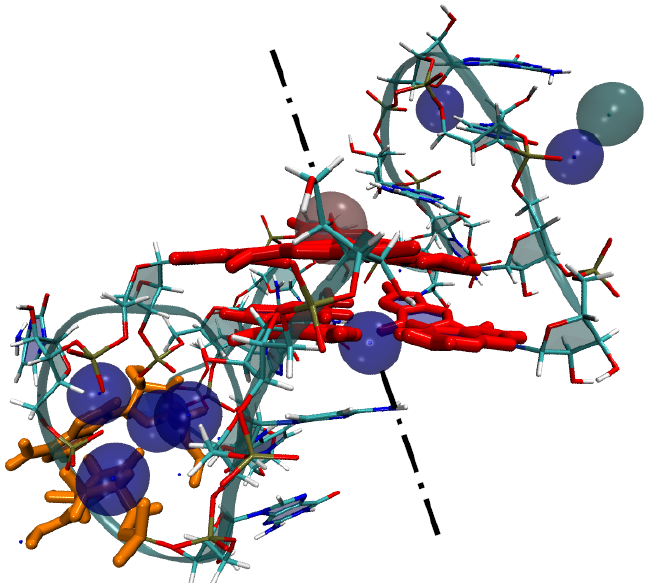
Figure A6. One of the most significant deformations observed for the seq2 quadruplex. The central loop surrounds four Na + ions (dark-blue spheres, down left), which—enhanced by inter-loop pi- stacking (orange)—tightens the structure in this region. The resulting sheer force acts on the core guanines (red), leading to the deformation of the GQ core. The dashed line shows the skewed main axis of the GQ